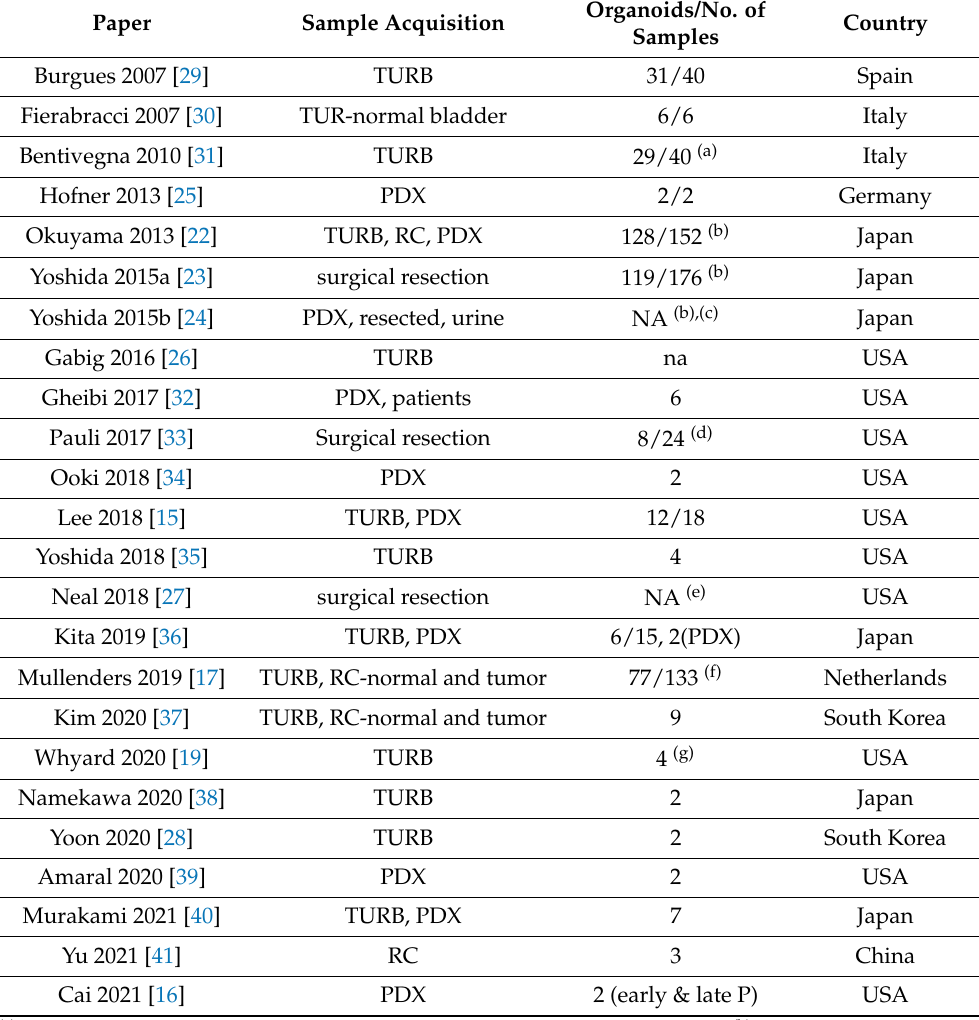
Table 1. Origin of the samples used in reviewed